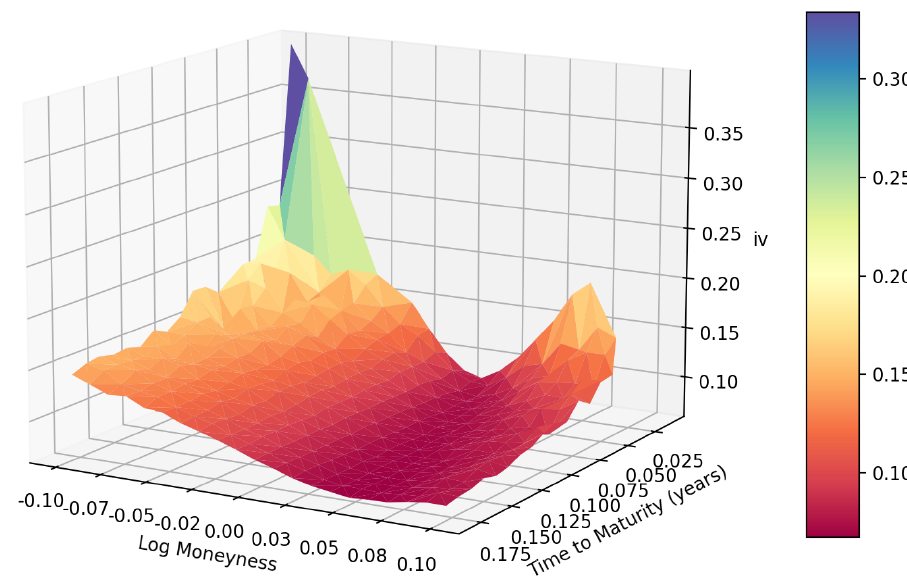
Figure 6. The rBergomi model’s IV surface inverted from S&P options data.